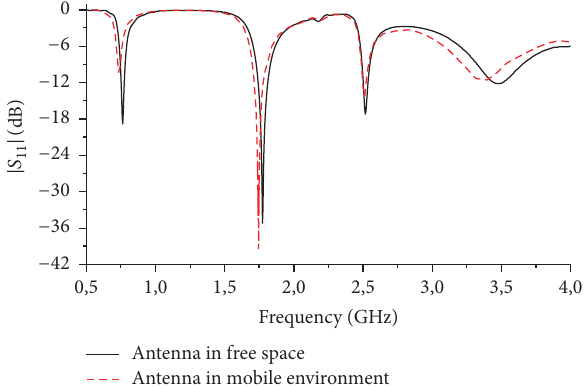
Figure 11: The simulated reflection coefficient of the proposed PIFA in